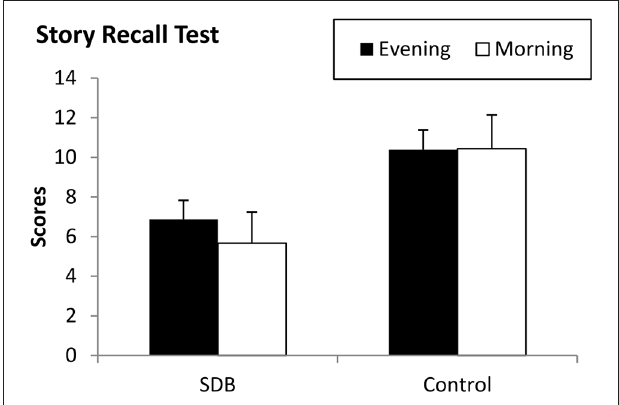
FIGURE 1 | Declarative memory performance in the evening and in the morning in the SDB and control groups. The dependent variable was the number of correctly recalled sentences. The overall declarative memory performance of the SDB group was significantly lower compared to the control group, but there were no offline changes in the memory performance in either group. Error bars indicate